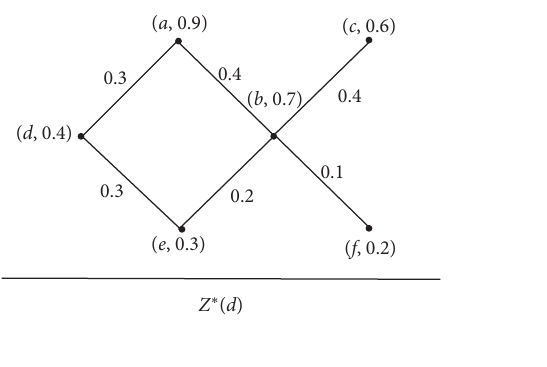
Figure 28: Fuzzy type-2 soft graph for national engineering